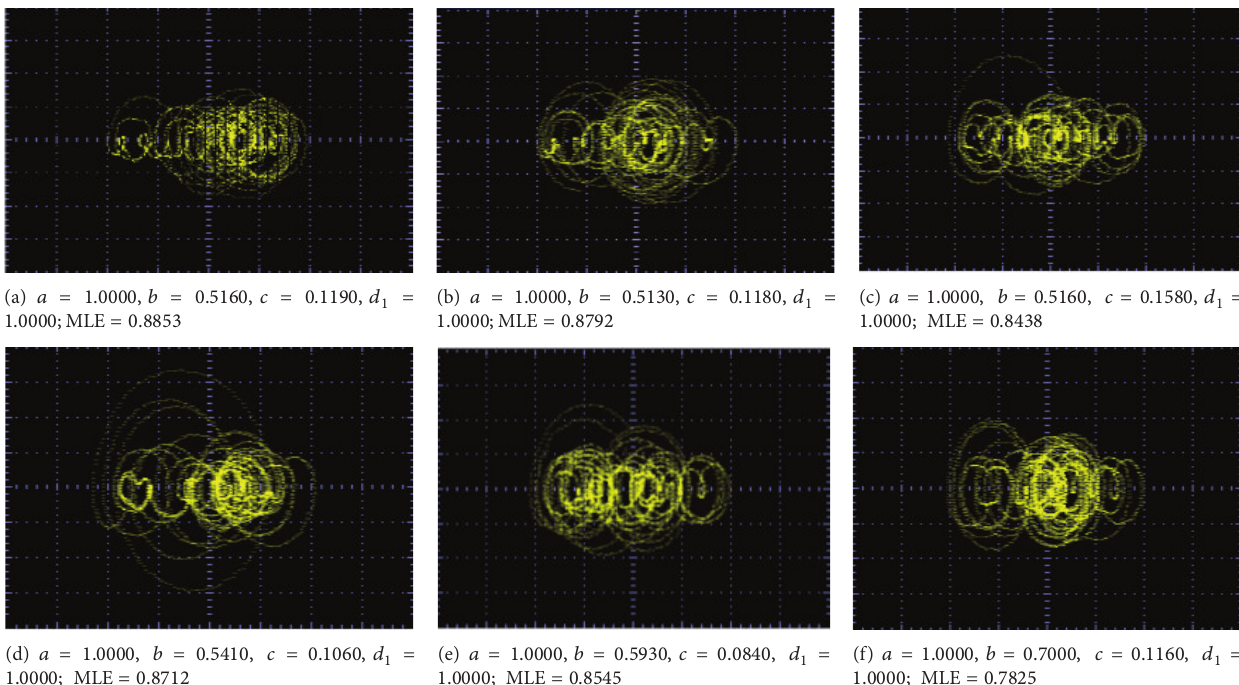
Figure 13: Optimized MLE for generating 10